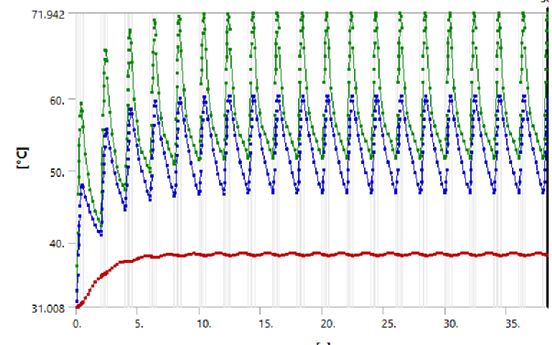
Fig. 10. Vacuum wall (green), average (blue), and wet wall (red) temperatures for reflector cone